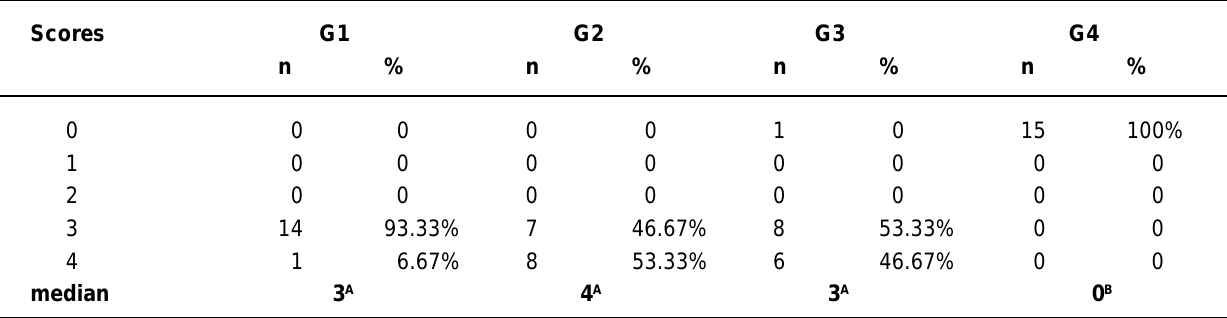
TABLE 1- Distribution of absolute (n) and relative (%) frequency and median of scores (Vita shade guide) obtained in the experimental groups 7 days post-bleaching